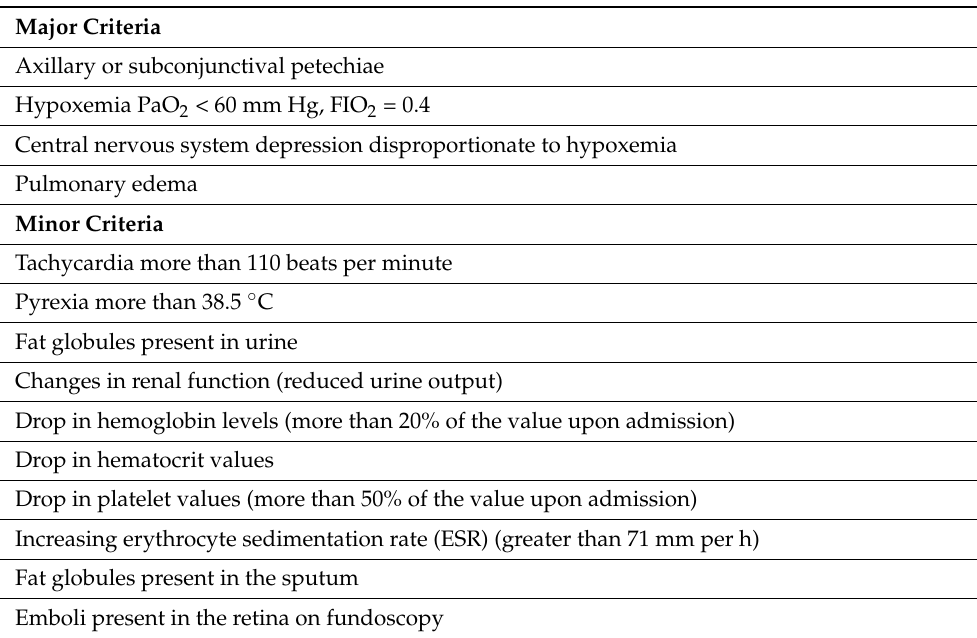
Table A1. Gurd and Wilson’s criteria: At least two major positive criteria plus one minor criterion, or four positive minor criteria, are suggestive of fat embolism syndrome